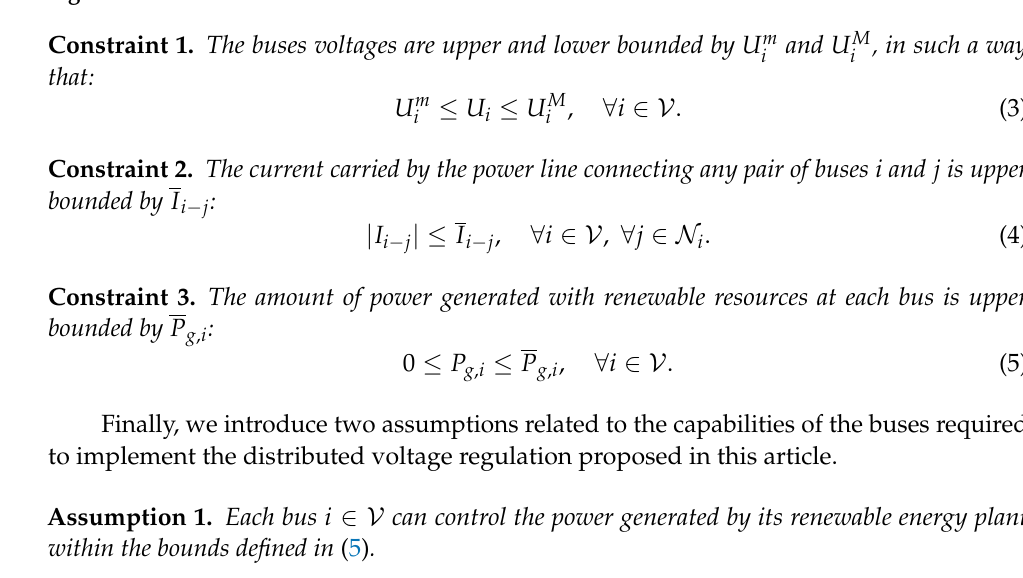
Figure 1. Current balance at bus i